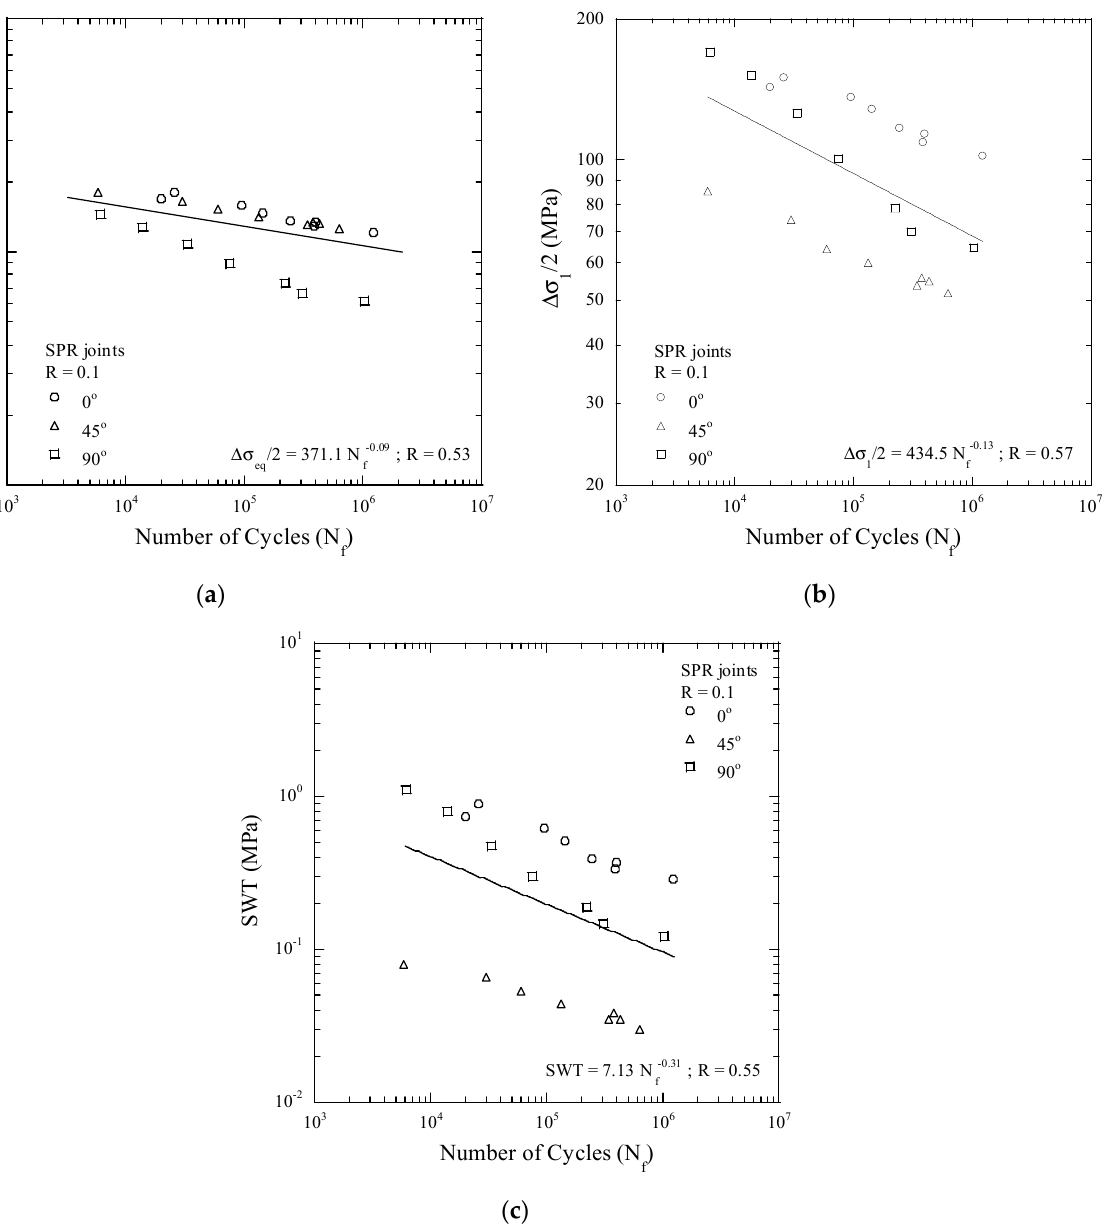
Figure 12. Experimental fatigue lifetimes of the SPR joint specimens under various loading conditions as a function of ( a ) the von-Mises stress, ( b ) the maximum principal stress, and ( c ) the SWT fatigue parameter.